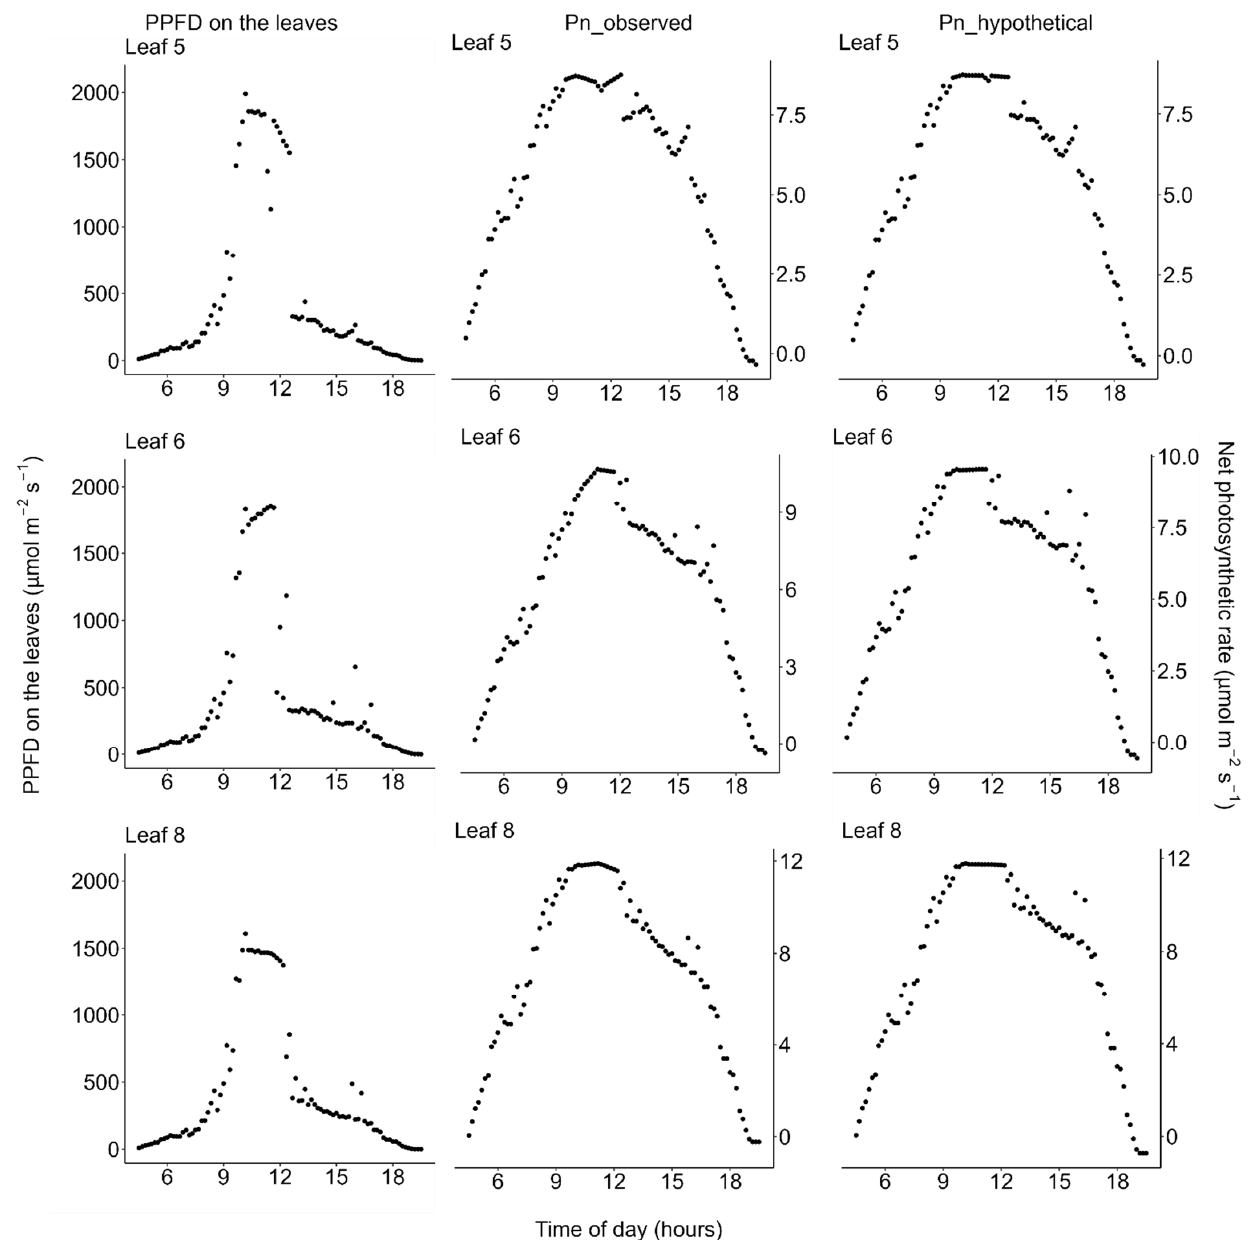
Figure 6. Diurnal courses of photosynthesis on the moderately hot days (22 and 23 July 2021). ( Left ) Photosynthetic photon flux density (PPFD) incident on each leaflet of Menyanthes trifoliata , ( middle ) P n_observed : actual net photosynthetic rate calculated based on both the observed diurnal change of photosynthetic light-response curve (Figure 5) and the diurnal change of PPFD, and ( right ) P n_hypothetical : simulated hypothetical net photosynthetic rate calculated by holding the photosynthetic light-response curve constant throughout the day, fixed at the curve observed in the early morning for each leaflet (Figure 5). Note that: (1) PPFD was measured on 23 July and the PPFD data were used to estimate photosynthesis on 22 July, the day on which the light-response curves shown in Figure 5 were measured, and (2) in the afternoon, the plants were shaded by trees on the pond shore (see Figure 1 for detailed weather conditions). All data are available in the Supplementary Materials.